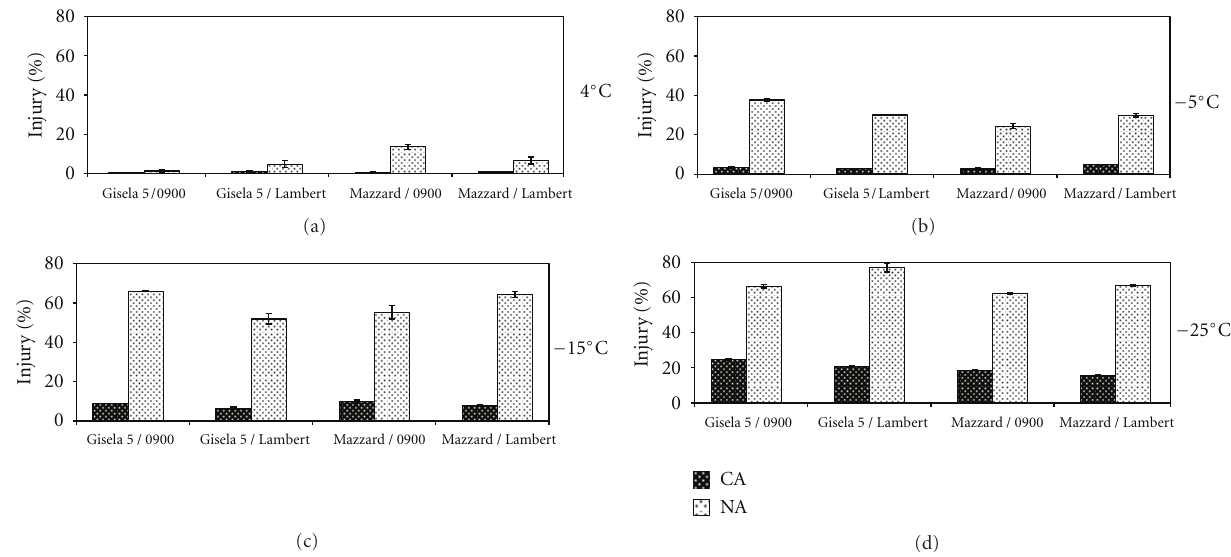
Figure 1: The changes of injury under low-temperature treatments in cold-acclimated (CA, in January) and nonacclimated (NA, in July) bark tissues of sweet cherry cultivars grafted on di ff erent rootstock. Error bars represent ± SE of three replications.